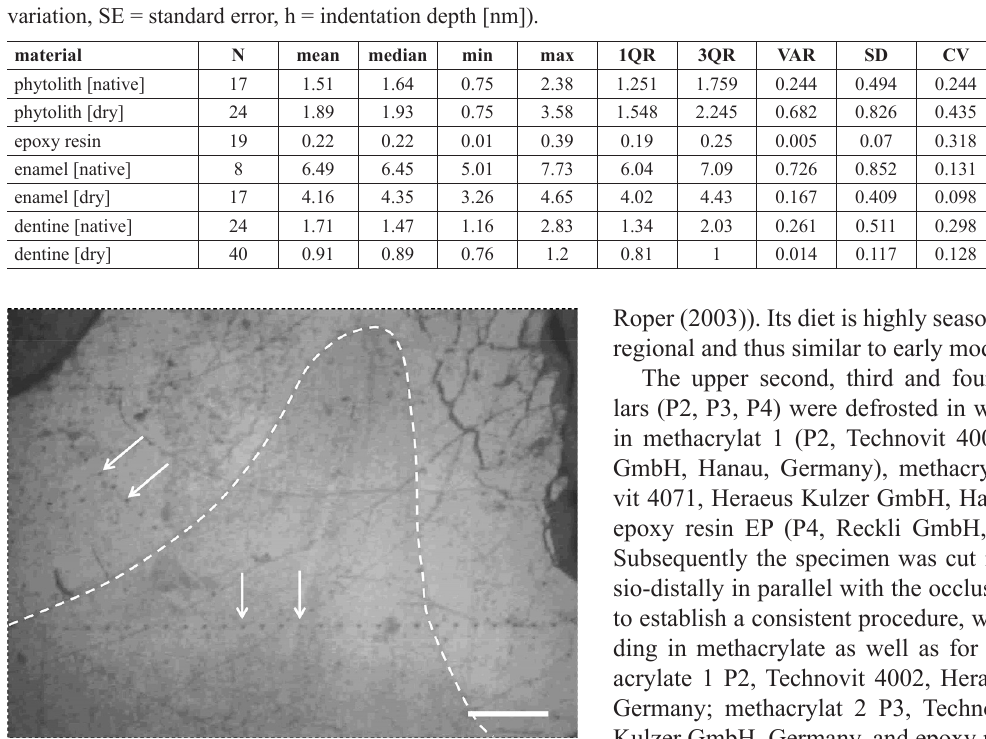
Figure 1. Polished slices of wild boar tooth tissue embedded in epoxy resin. The enamel-dentine junction (EDJ) is indicated by a dotted line. Some of the several marks of nano-indentation are indicated by arrows (scale bar = 200